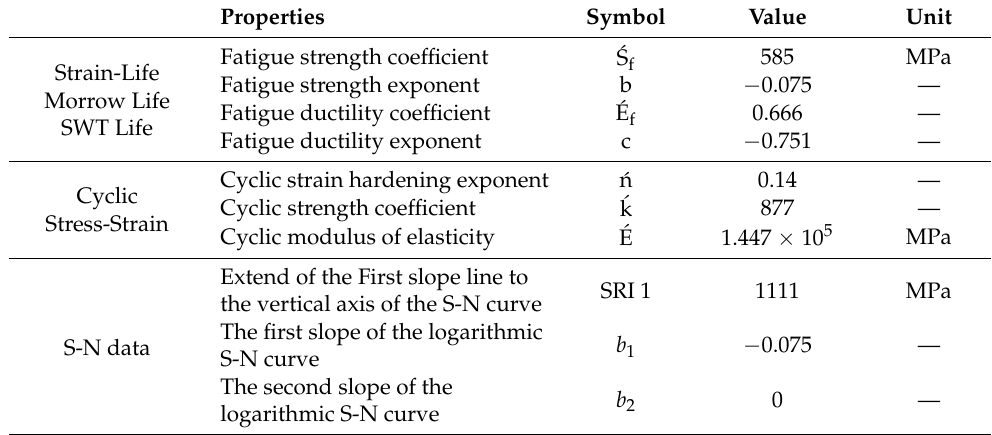
Table 2. Mechanical properties of ductile cast iron [53].